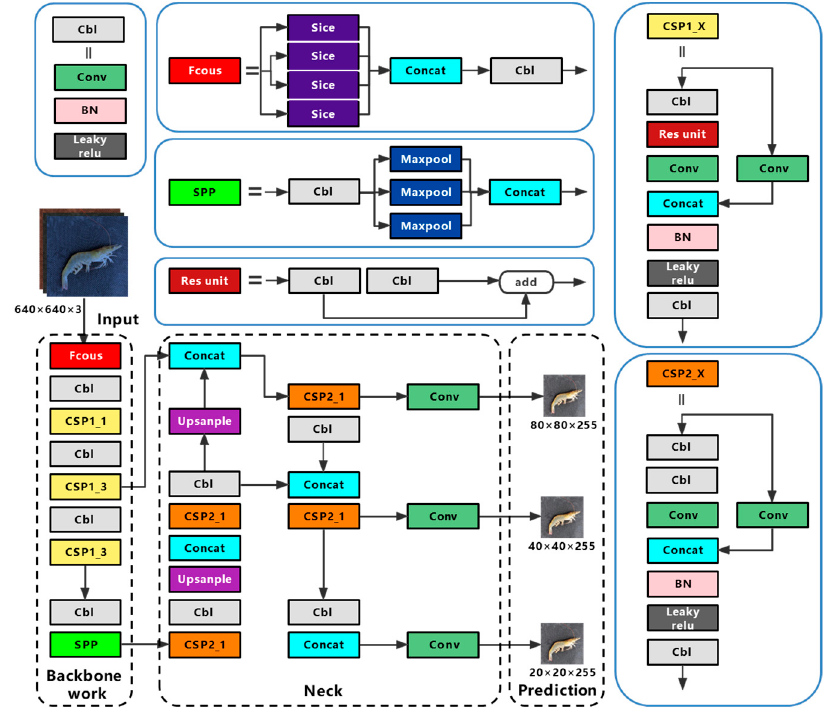
Figure 1. The structure of YOLOv5s network . BN (Batch Normalization), SPP (spatial pyramid pooling), CSP (cross stage partial, CSP_1 with residual structure, CSP_2 without residual structure).